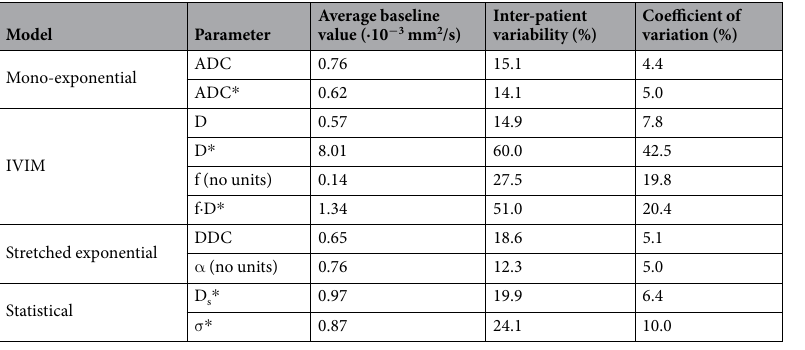
Table 1. Average pre-treatment values of the various diffusion parameters (all units mm 2 /s except where shown) as well as inter-patient variability, and coefficient of variation as